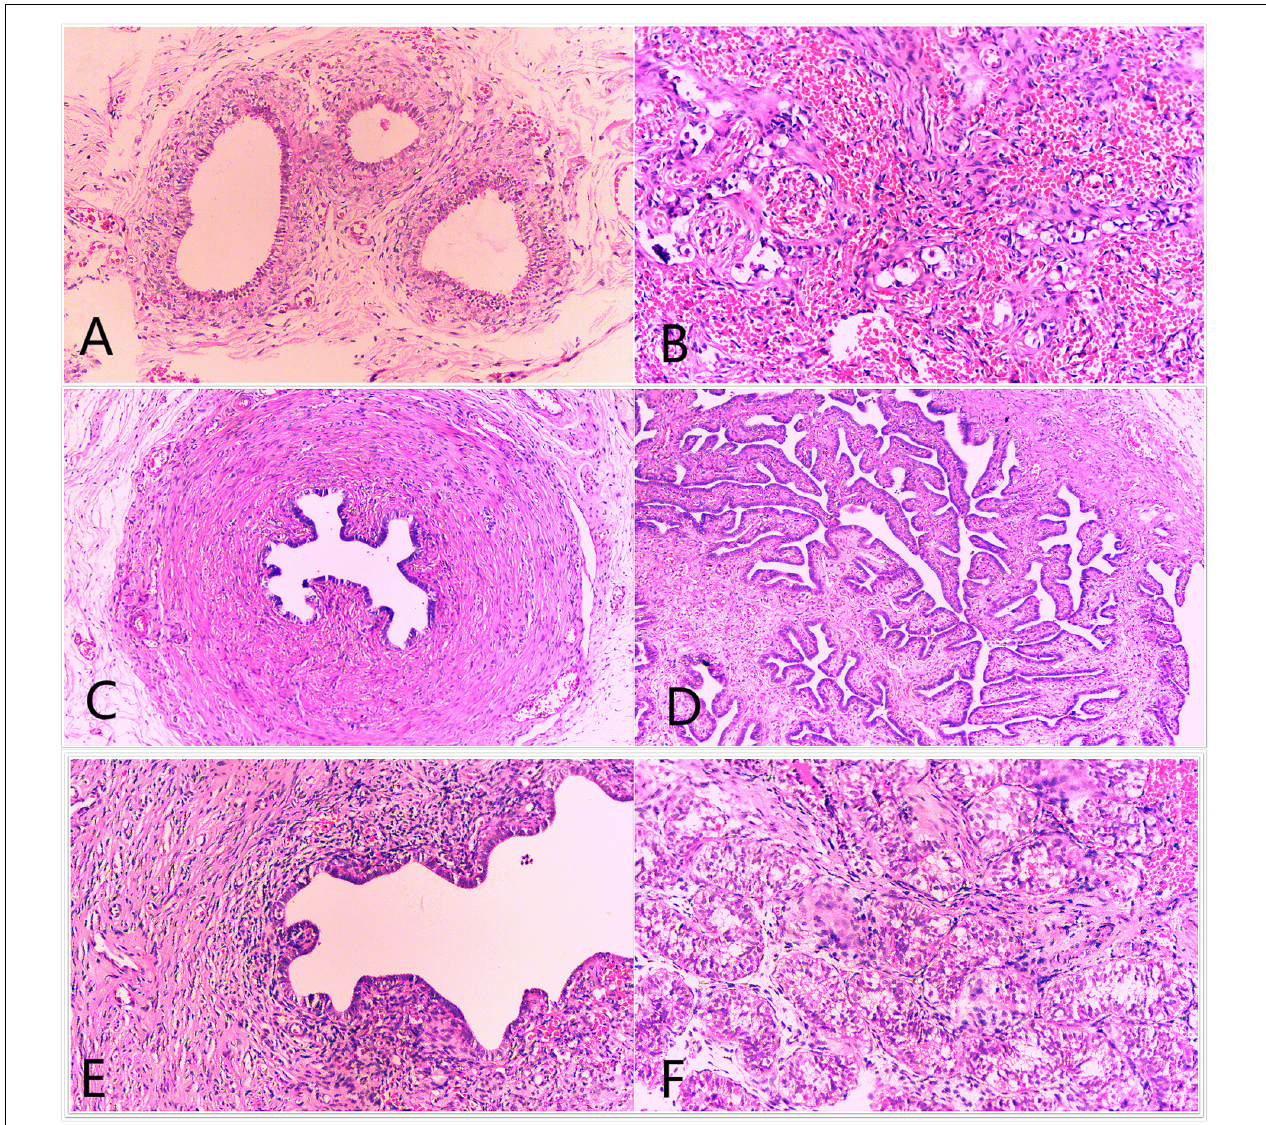
FIGURE 1 | H&E staining of the biopsy gonad tissues from a severest DSD patient with XYY in blood (A66). For A66, surgical exploration of scrotum and groin revealed (A) the structure of epididymis, (B) the structure of ovary (primodial follicles are visible), (C) the structure of vas deferens, (D) the structure of fallopian tubes, and (E) structure of uterus. For A66, right testis biopsy revealed the dysplasia of spermatogenic tubules (F)